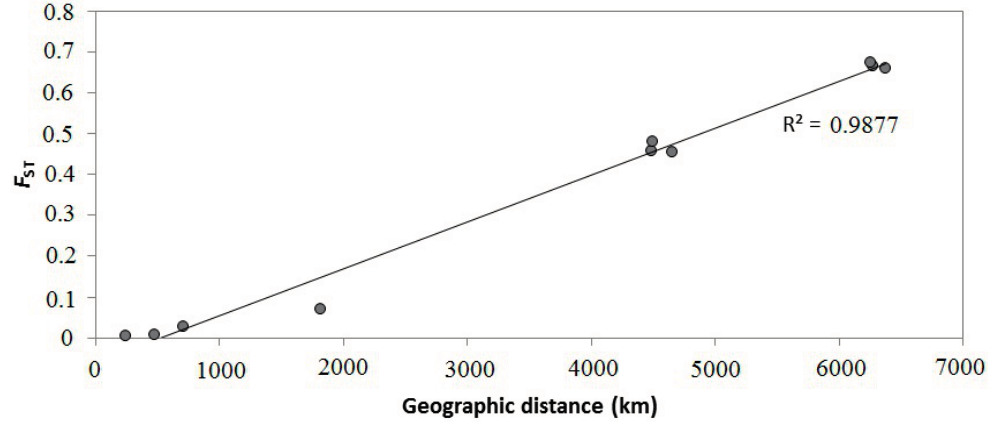
Figure 5. Isolation by distance (IBD) used Mantel tests (10,000 permutations) for five